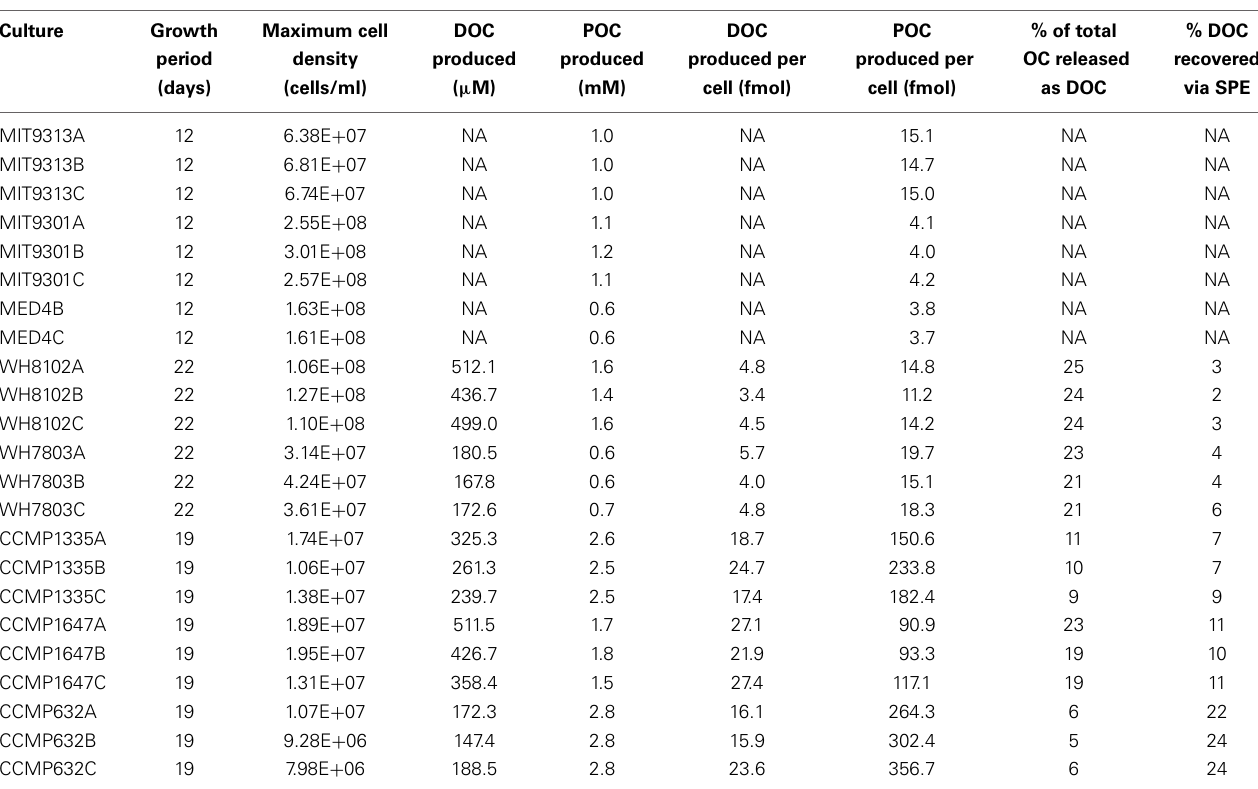
Table 2 | Biomass and organic carbon production by phytoplankton cultures tested in this study. Culture